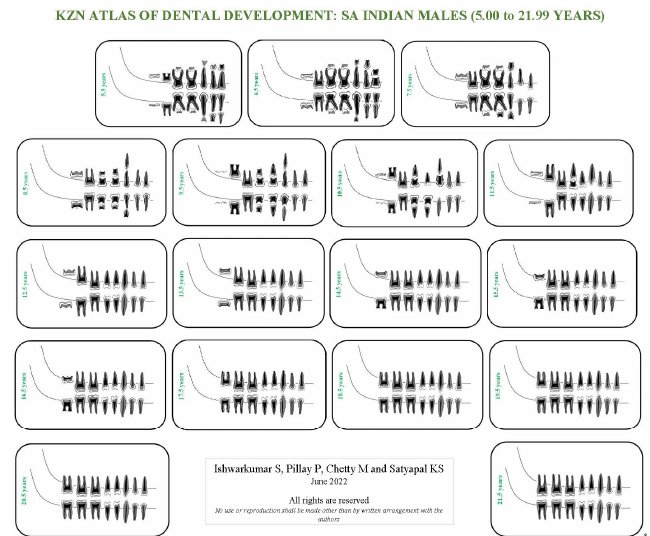
Figure 4. KZN Atlas of dental development for South African Indian males.